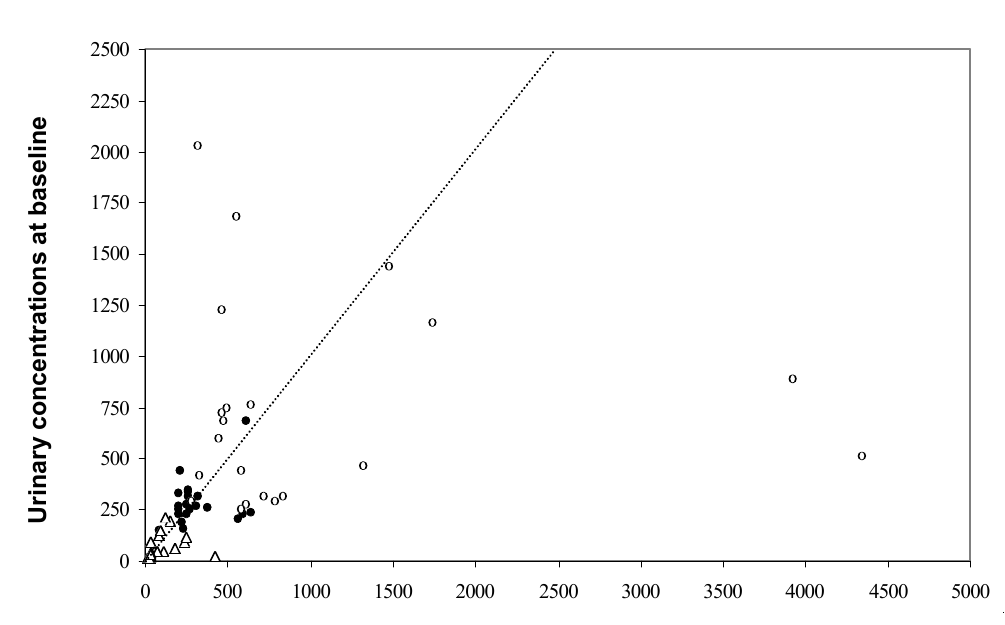
Figure 1. Effect of meloxicam on urinary excretion (all concentrations as µ mol per mol creatinine) of neopterin (filled circles), xanthopterin (open circles) and biopterin (triangles), straight line indicates ideal regression line with no changes between measurements at baseline and during treatment.